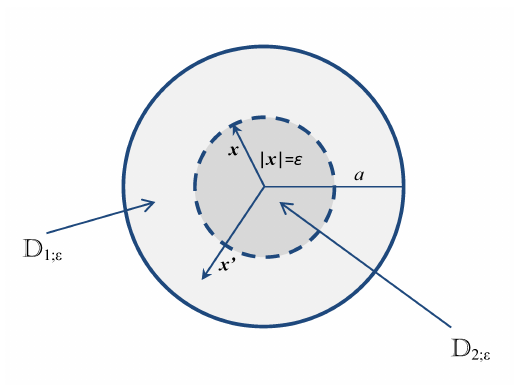
Figure 13: Integration over the domain D 1; (cid:15)